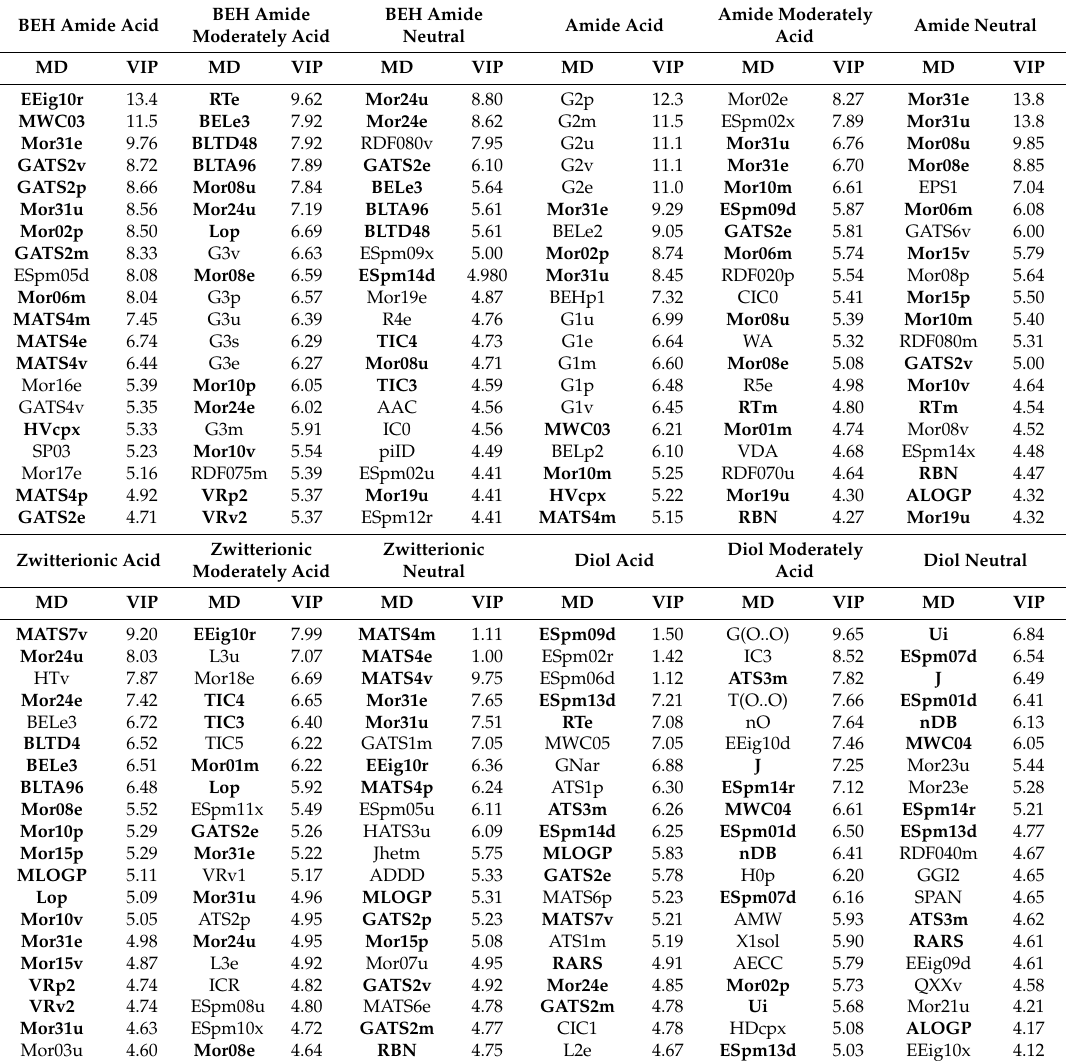
Table 2. Variable importance on projection (VIP) scores of the twenty most important molecular descriptors (MD) for each chromatographic